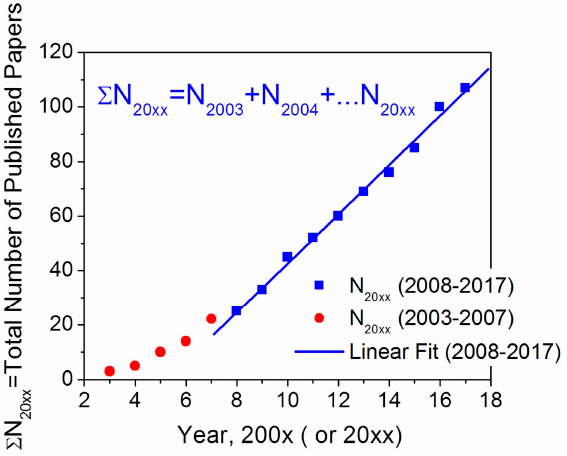
Figure 1. Total number of published papers reporting the properties of liquid crystals doped with ferroelectric nanomaterials versus time.